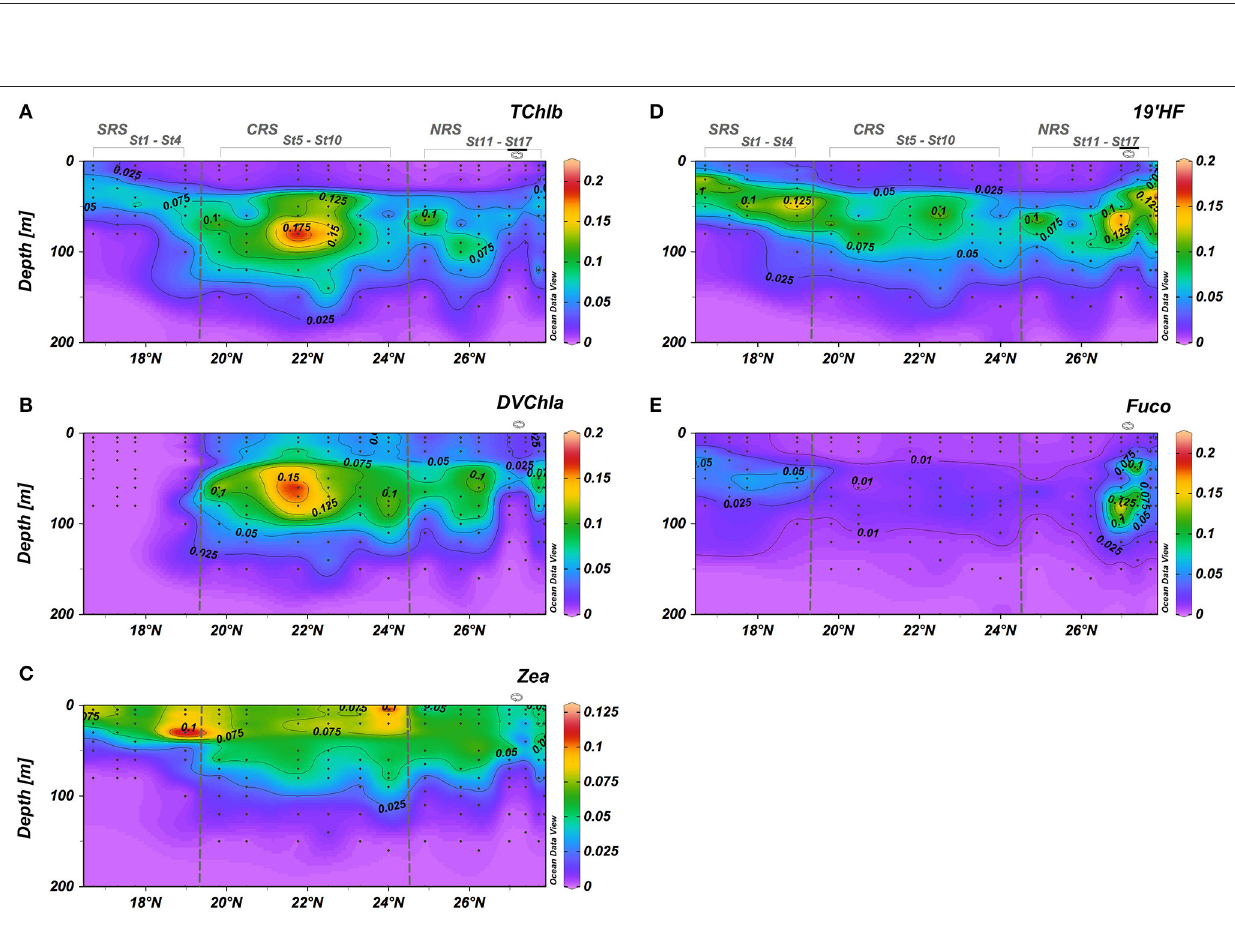
Frontiers in Marine Science | www.frontiersin.org